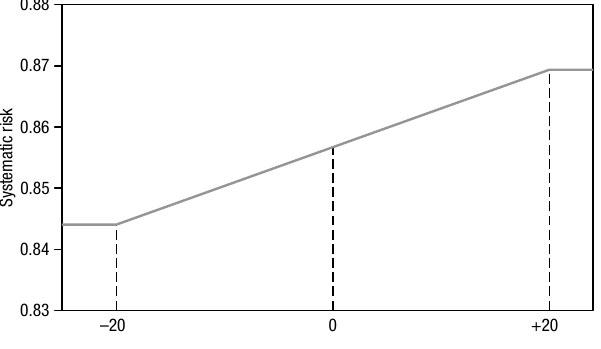
Note: Figure 1 refers to the results in Table 3 for the +/–20 window. The window shows the evolution of systematic risk within the event window for the set of 185 securitizations on and around the registry